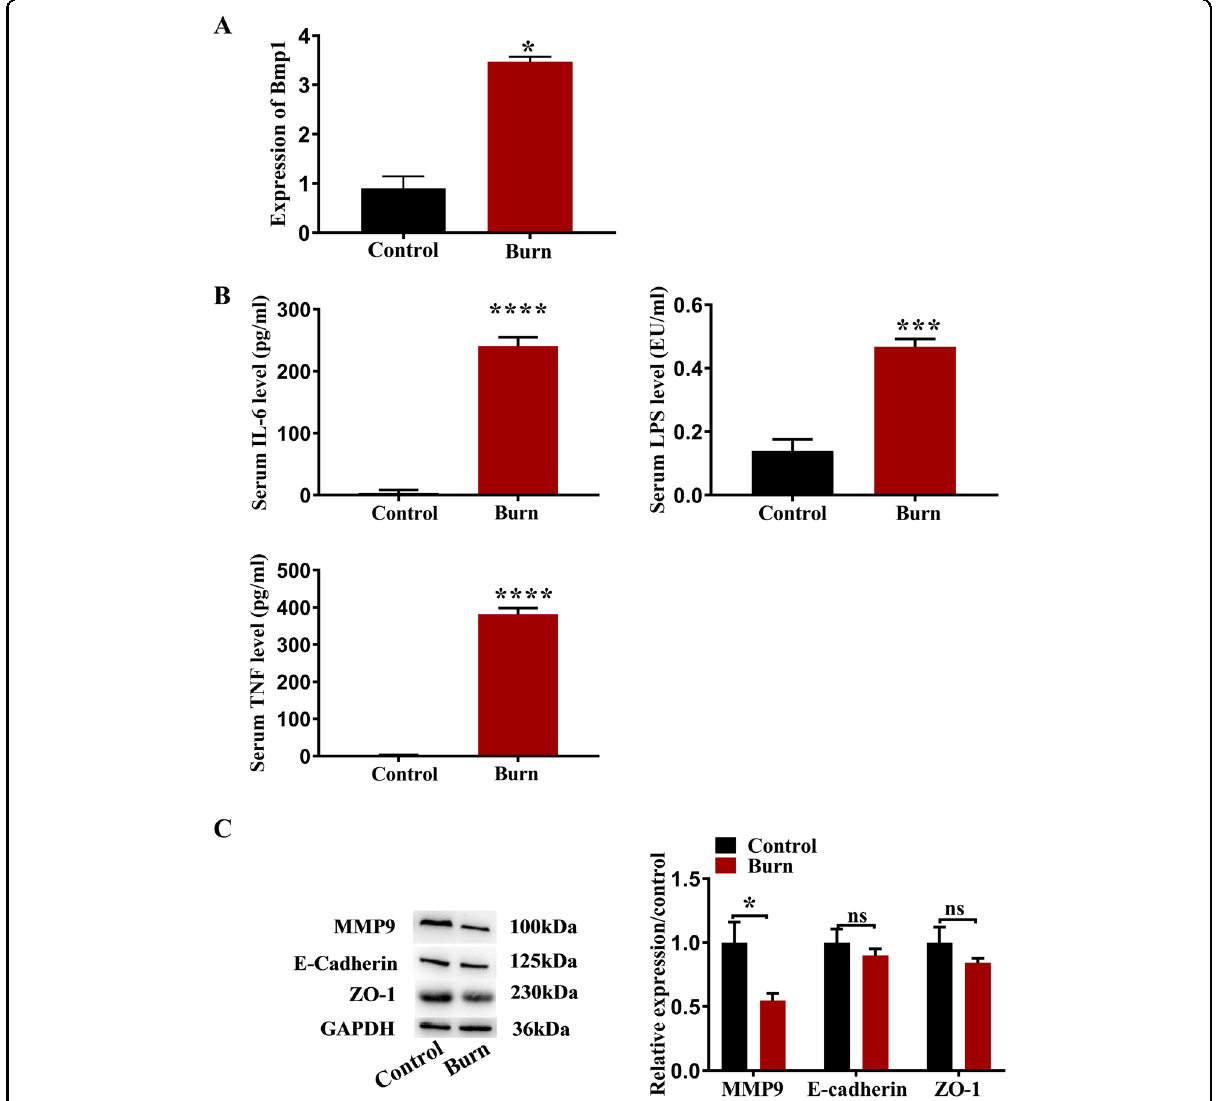
Fig. 1 Expression of Bmp 1, TNF- α , IL-6, LPS, MMP-9, E- cadherin, and ZO-1 in intestinal tissue of burned mice. A Expression of Bmp1 ( n = 10), B TNF- α , IL-6, LPS ( n = 10), C cell migration-related protein MMP9, E-cadherin, and ZO-1 were detected by qRT-PCR, ELISA, and western blot, respectively ( n = 10). All data were demonstrated as mean ± standard deviation (SD) from three independent experiments performed in duplicate. * p < .05, *** p < .001, and **** p < .0001 were all signi fi cant